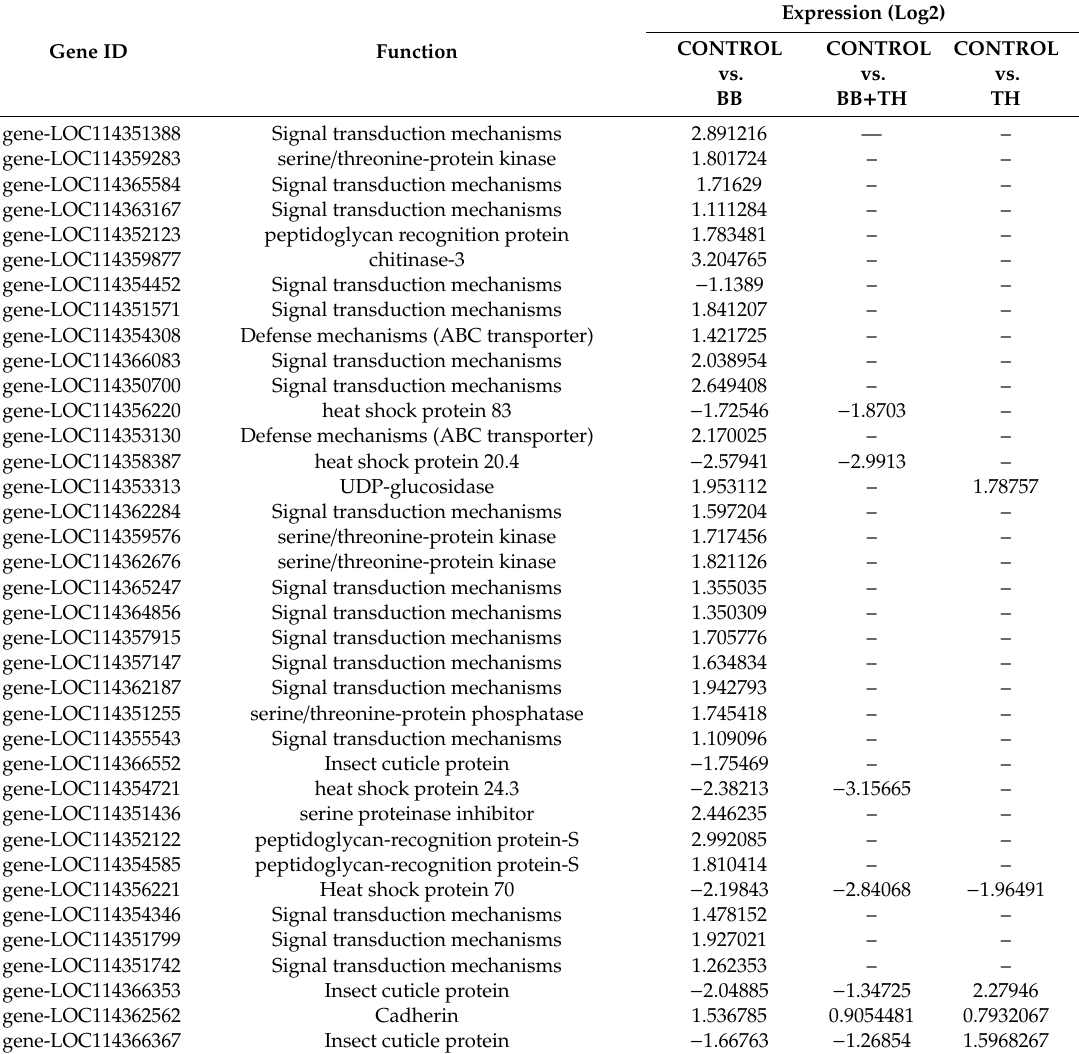
Summary of immune-related genes identified in O. furnacalis transcriptome after entomopathogenic fungal